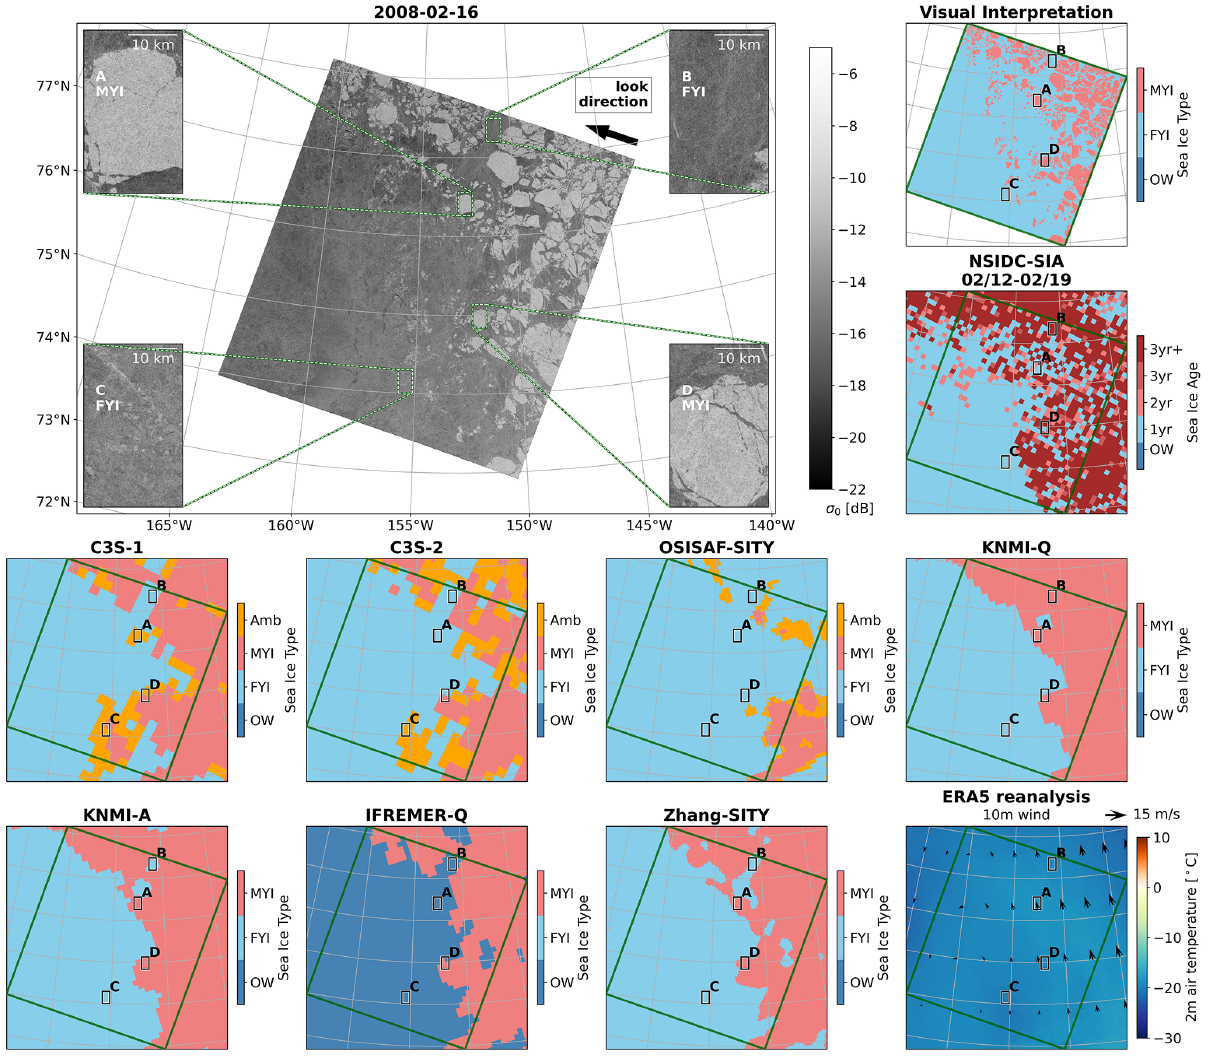
Figure 12. RS-1 image, ice type distribution from seven SITY products (C3S-1, C3S-2, OSISAF-SITY, KNMI-Q, KNMI-A, IFREMER-Q and Zhang-SITY), weekly NSIDC-SIA product and visual interpretation result based on the SAR image, along with 2m air temperature and 10m wind from ERA5 reanalysis on 16 February